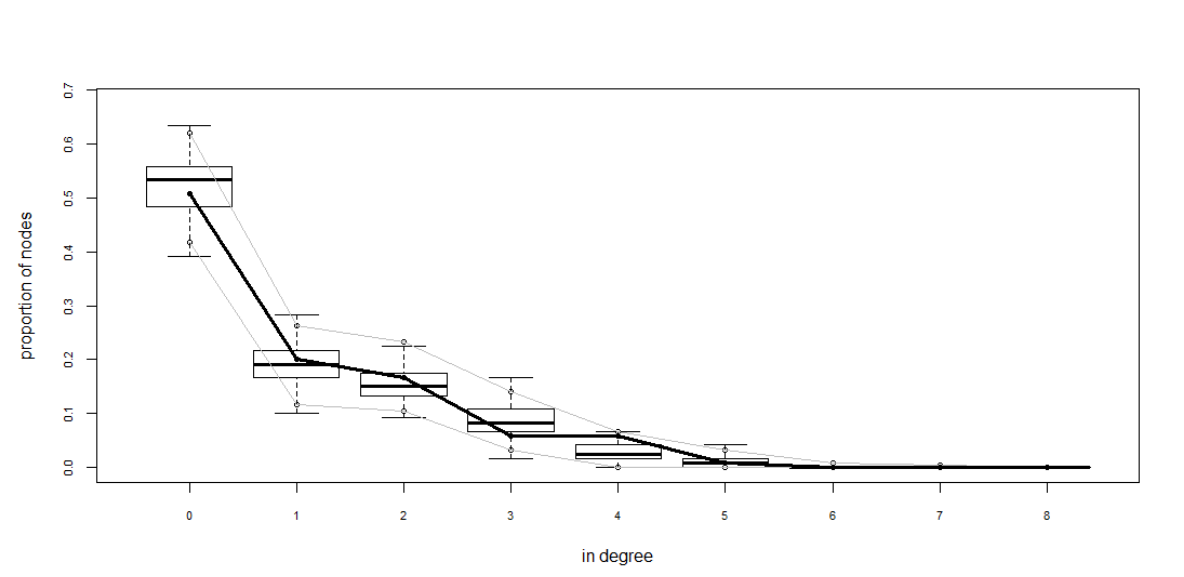
Figure A1.3. Goodness of Fit Diagnostics for Indegree Distribution